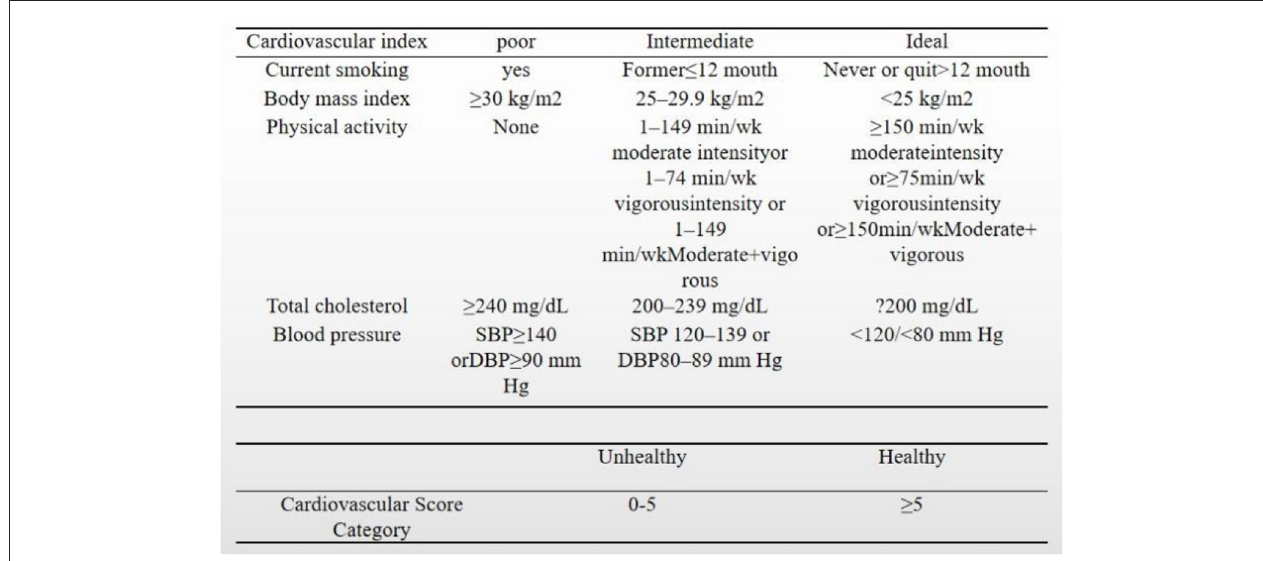
FIGURE 1 | Cardiovascular health